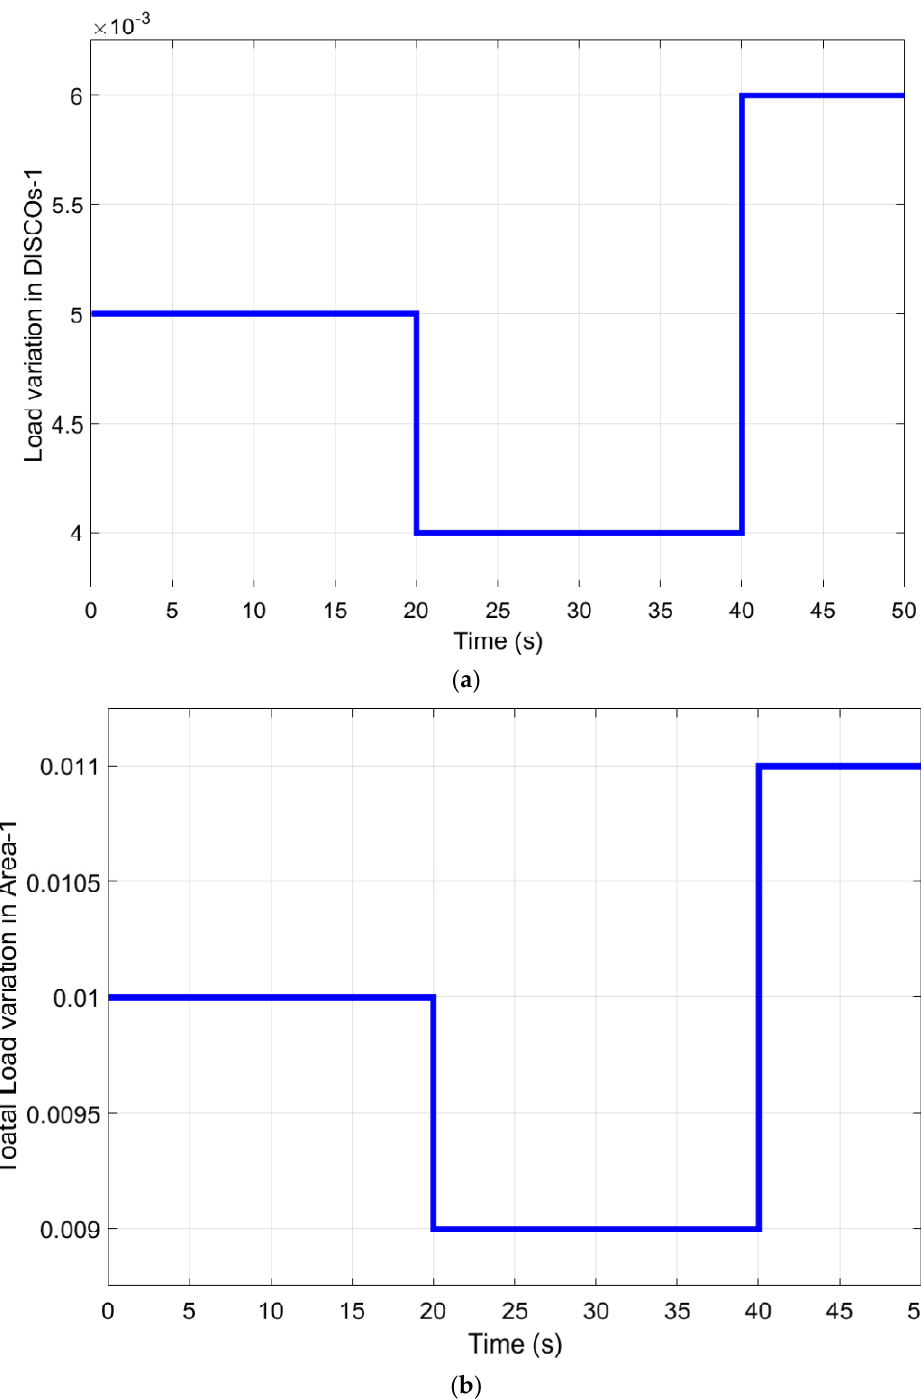
Figure 11. ( a ) Dynamic load changes for DISCO–1; ( b ) dynamic load changes for area–1.